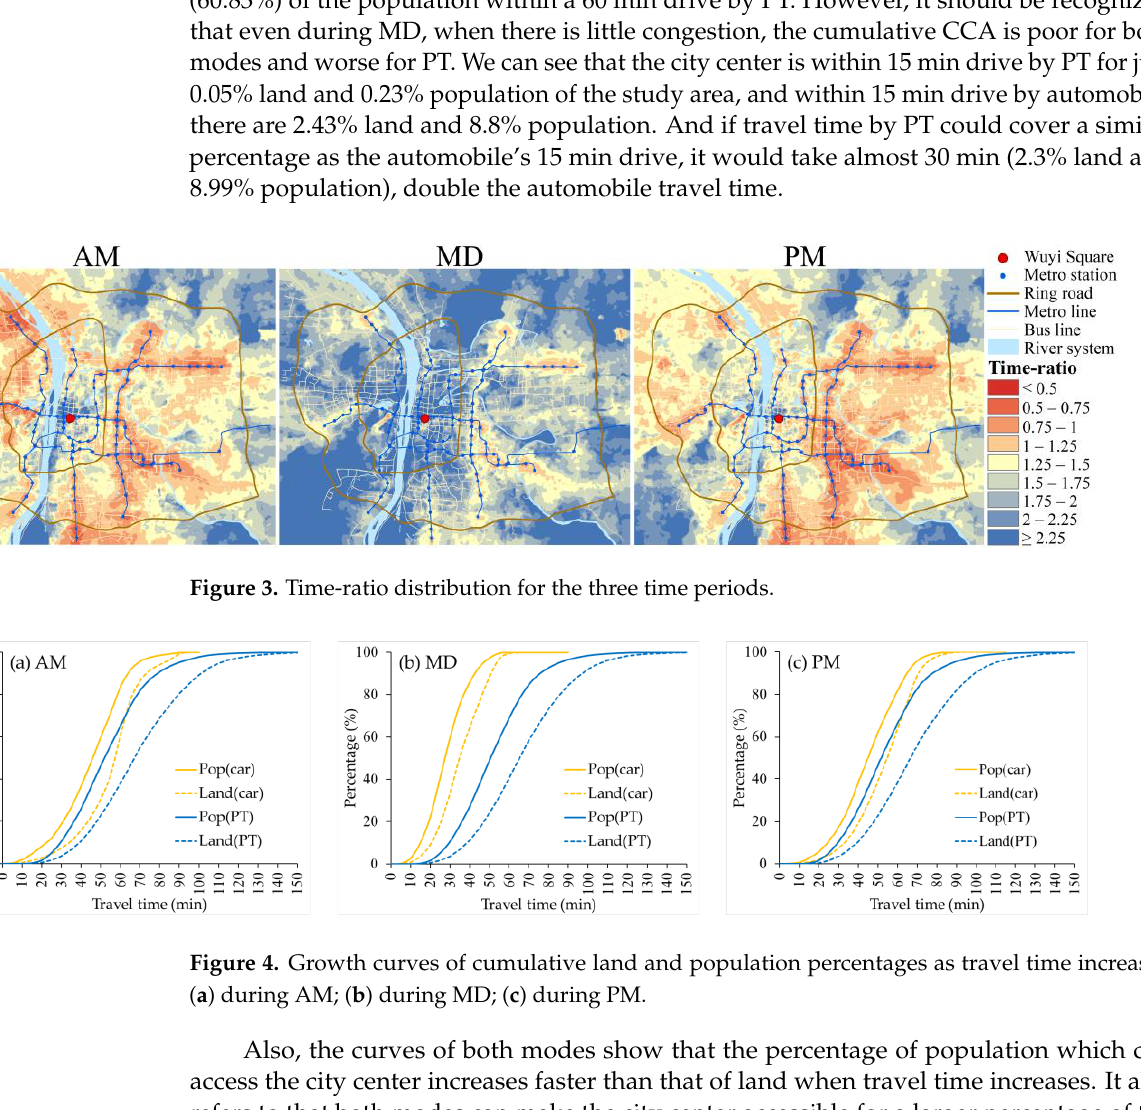
Figure 4. Growth curves of cumulative land and population percentages as travel time increases: ( a ) during AM; ( b ) during MD; ( c ) during PM.